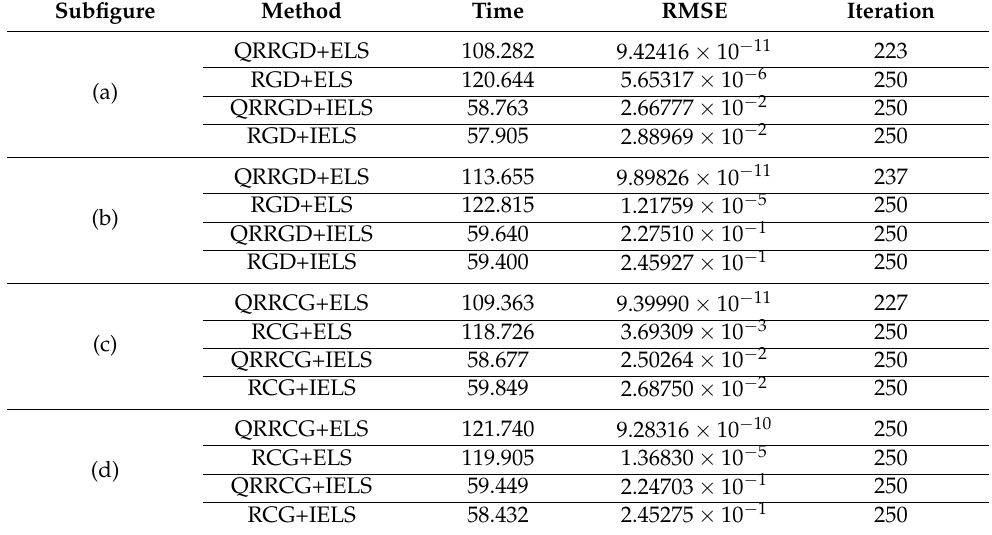
Figure 3. Performance comparison of RGD ( a , b ) and RCG ( c , d ) with and without QR factorization. Simulations were carried out on square matrices M 1 ( a , c ) and M 2 ( b , d ). We apply the ELS and IELS to find the step size. The parameter values are n 1 = 2000, n 2 = 2000, r = 18, and p = 0.05. Table 3. Computational results for Figure 3 with matrices size of 2000 × 2000. The time is rounded to three decimal places and RMSE is rounded to five decimal